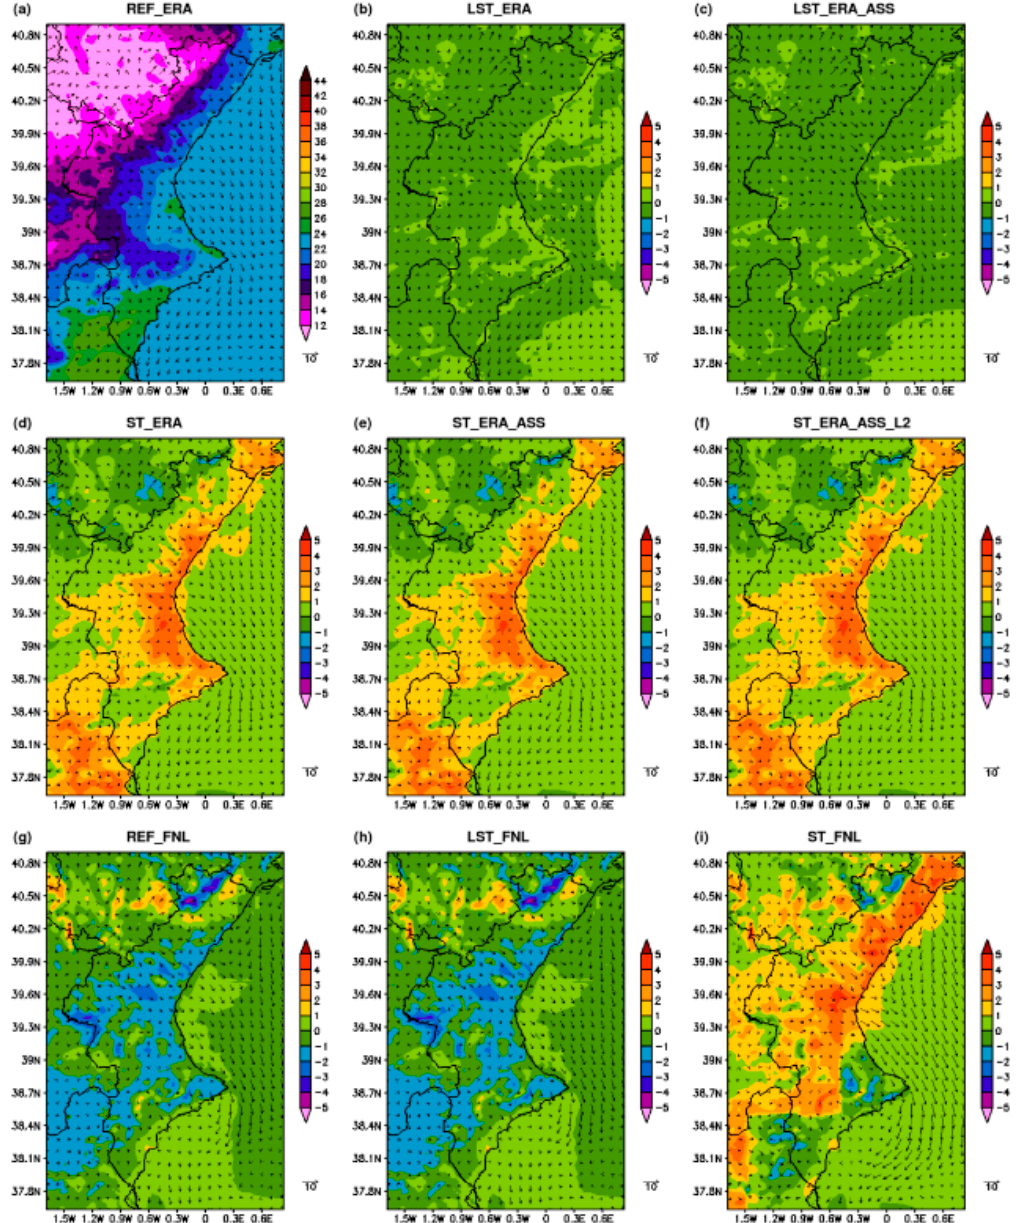
Figure 9. Same as Figure 6, but for the forecasted 2-m minimum temperature (°C) and near-surface wind field (m/s) at 06 UTC.